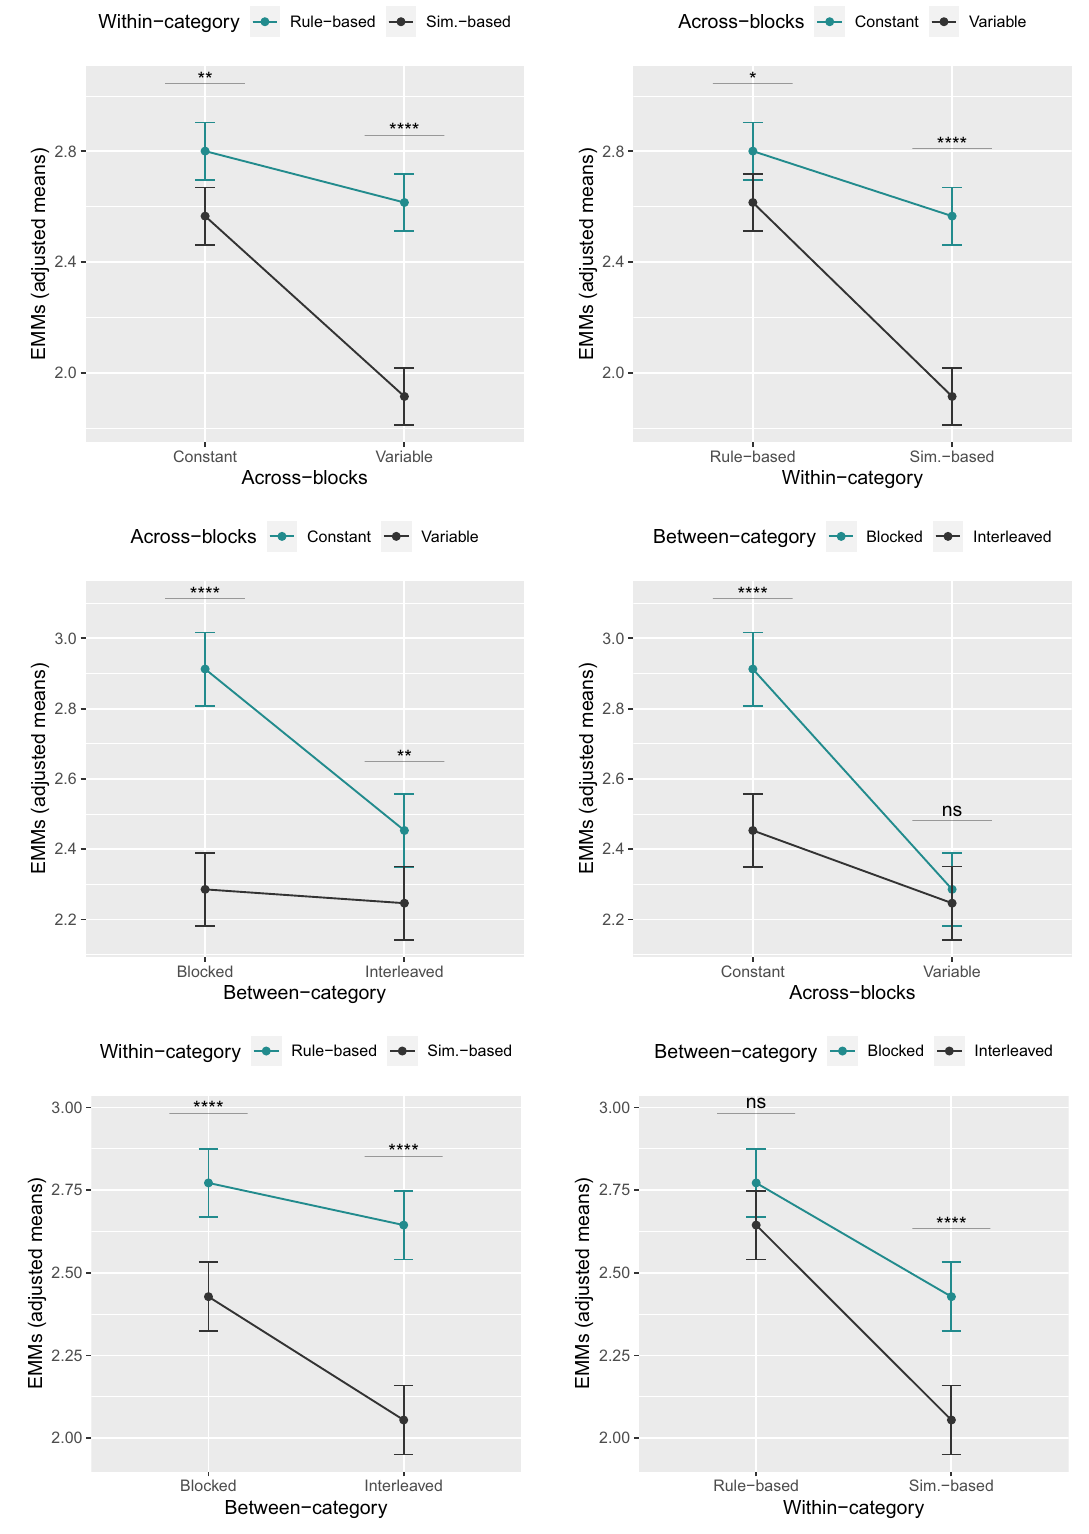
Figure 5. Simple main effect analysis for the significant interactions. Estimated marginal means (EMMs) for the interaction between within-category and across-blocks orders (on the top), between between-category and across-blocks orders (in the middle), and between within-category and between-category orders (on the bottom). Significance values were adjusted using the Benjamini-Hochberg correction with a FDR ≤ .05